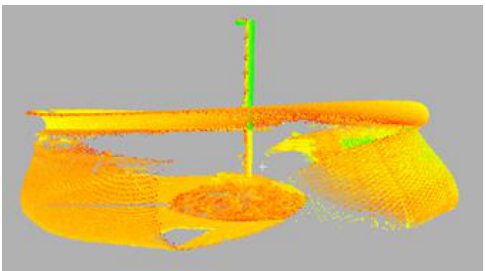
Figure 9. 3 D laser scan after refraction correction for Trial 1 [35,36] (used with permission).